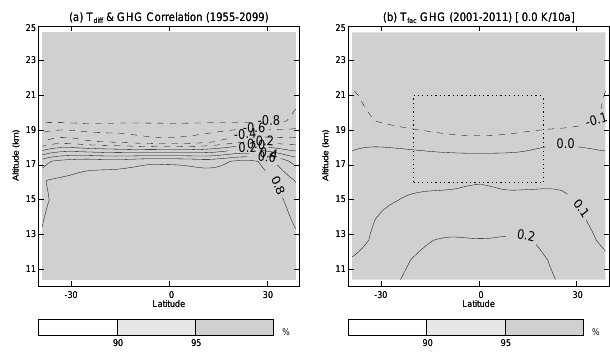
Figure 5. Same as Fig. 3 but for the impact of the QBO2 (see text for details) by comparing the Natural and the NOQBO experiments; contour interval is (a) 0.2 and (b) 0.2Kdecade − 1 .